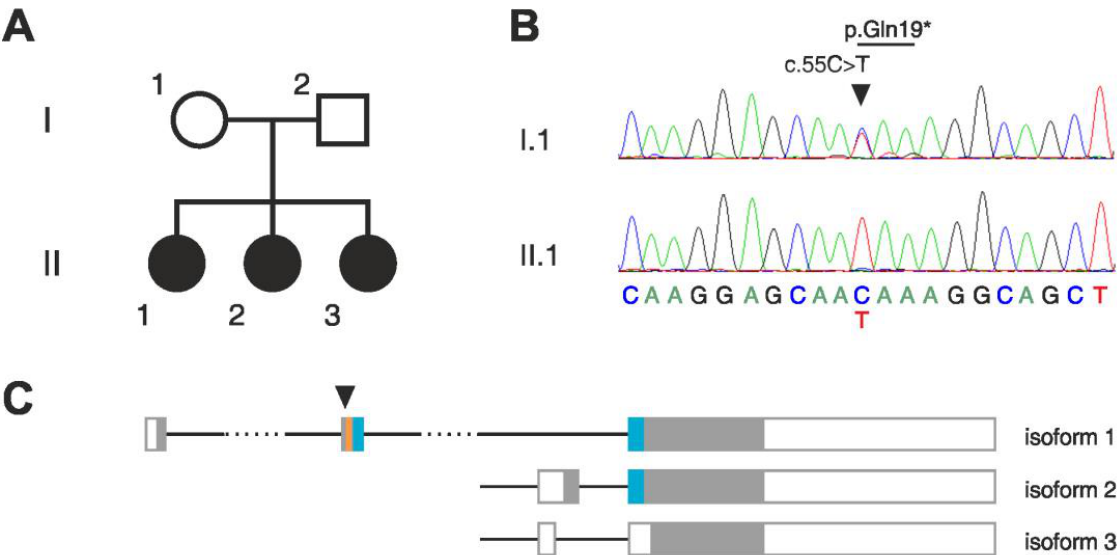
Figure 1. Homozygous stop-gain mutation in BATF2 in a family with three affected children. ( A ) Pedi- gree of the affected family. ( B ) Sequencing chromatograms of isoform 1 cDNA showing the BATF2 p.Gln19* mutation in heterozygous state in the mother (I.1) and in homozygous state in the index patient (II.1). ( C ) Structures of the three transcript isoforms of BATF2 . Filled boxes, protein coding re- gion; empty boxes, non-coding region; orange, basic region; blue, leucine-zipper domain; arrowhead, position of the mutated nucleotide. Note that only isoform 1 contains the complete basic-leucine zipper (bZIP) domain which is required for DNA binding and